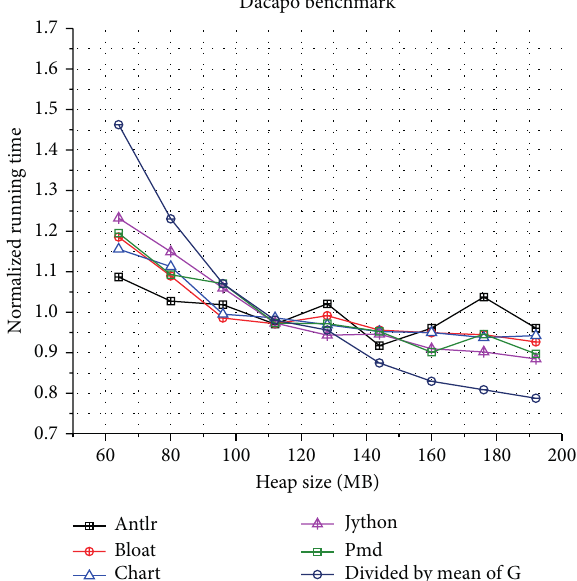
Figure 6: Dacapo benchmark results for our CGC with different heap sizes.